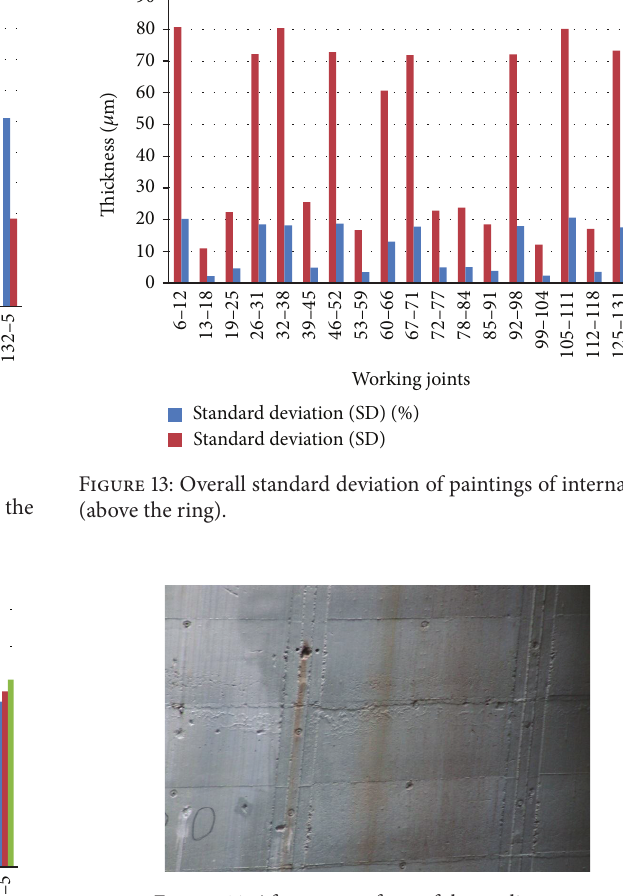
Figure 14: After a year of use of the cooling tower.